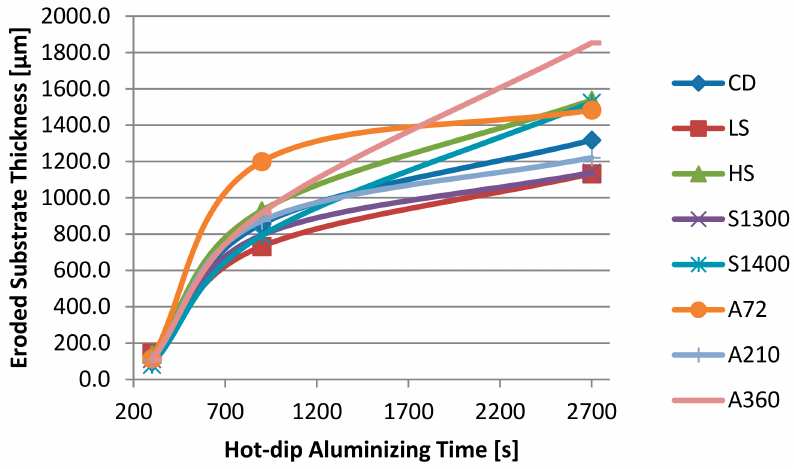
Figure 8. Thickness of the surficial layer of the steel substrate eroded by liquid